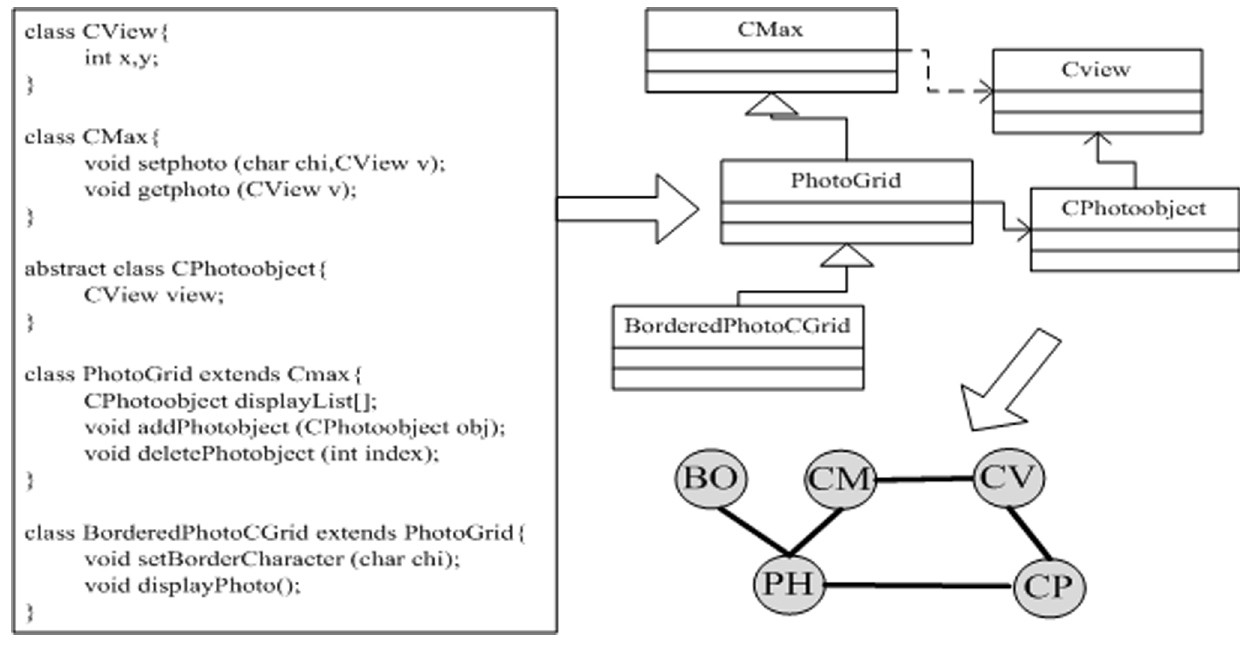
Figure 1. The extraction from codes to software network. The process is as follows: The UML class diagram is first abstracted from the source code and subsequently converted to the undirected software network.